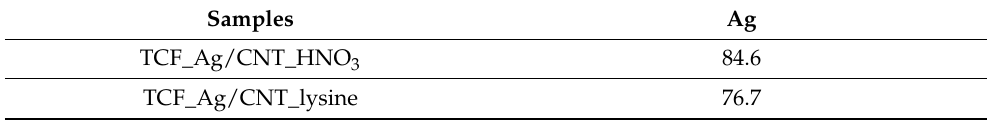
Table 1. Ratio of Ag element (mass %) in TCF_Ag/CNT